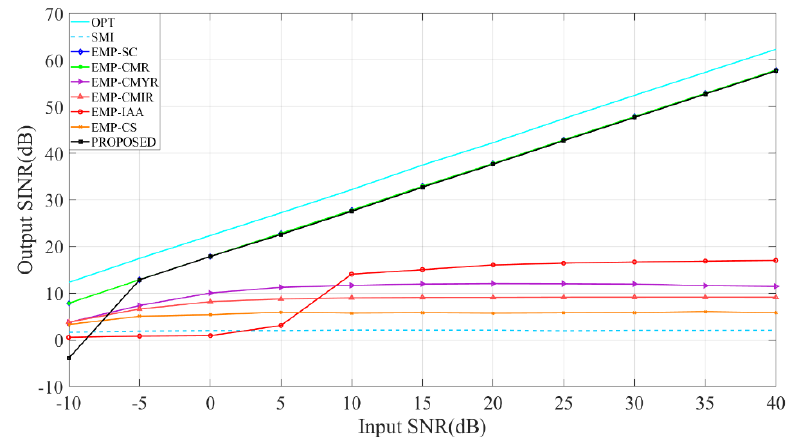
Figure 4. Analysis of the impact of Input SNR on Output SINR.